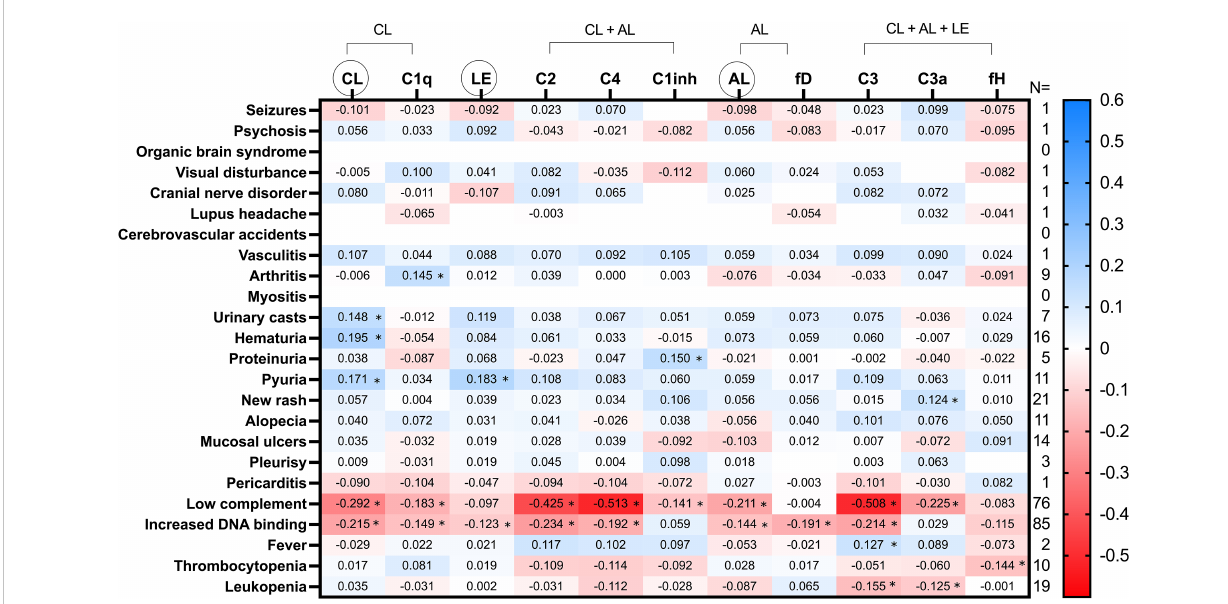
FIGURE 1 Heatmap of SLEDAI-2K items relation to C pathways activation and serum molecules. Values in the cells represent Spearman ’ s rho coef fi cient (* denotes p value < 0.05). Positive and negative correlations are shown in blue and red, respectively. The number of patients who met each SLEDAI- 2K Item is shown in the right margin. CL, classical; AL, alternative; LE, lectin; fD, factor D; fH, factor H. CL, LE and AL in circles refer to the functional tests of these cascades.